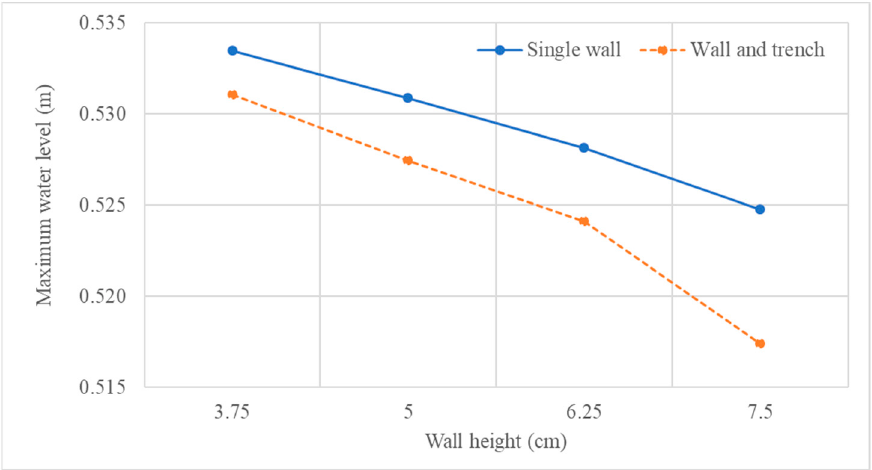
Figure 21. Comparison of maximum water levels observed at location D.